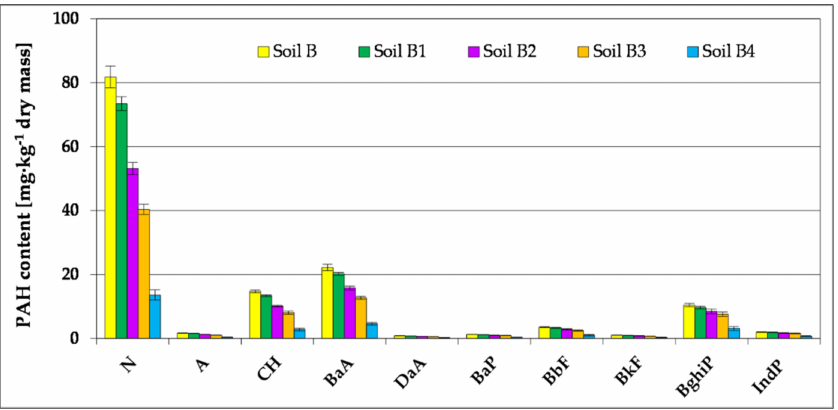
Figure 2. Alternation in polycyclic aromatic hydrocarbons (PAH) contents after consecu- tive stages of soil B purification in laboratory conditions—ex-situ method. (Soil B) raw soil; (Soil B1) soil after basic bioremediation; (Soil B2) soil after inoculation with I bioprepara- tion (1st series); (Soil B3) soil after inoculation with I biopreparation (2nd series); (Soil B4) soil after inoculation with II biopreparation (3rd series). Naphthalene (N), Anthracene (A), Chryzene (CH), Benzo(a)anthracene (BaA), Dibenzo(a,h)anthracene (DaA), Benzo(a)pyrene (BaP), Benzo(b)fluoranthene (BbF), Benzo(k)fluoranthene (BkF), Benzo(ghi)perylene (BghiP), Indeno(1,2,3- cd)pyrene